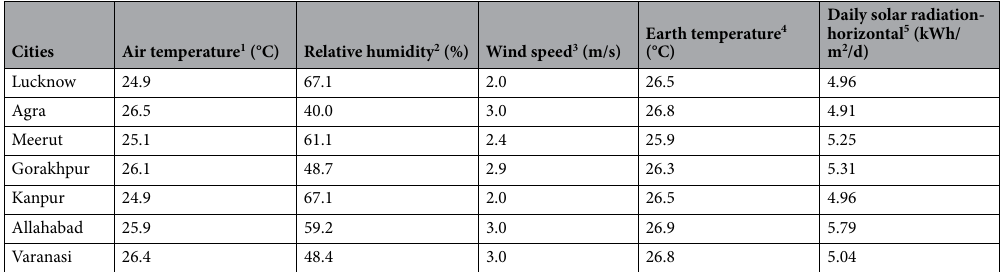
Table 3. Annual weather data of all the cities. Superscript1, 2-Ground data & 3, 4, 5- NASA data.